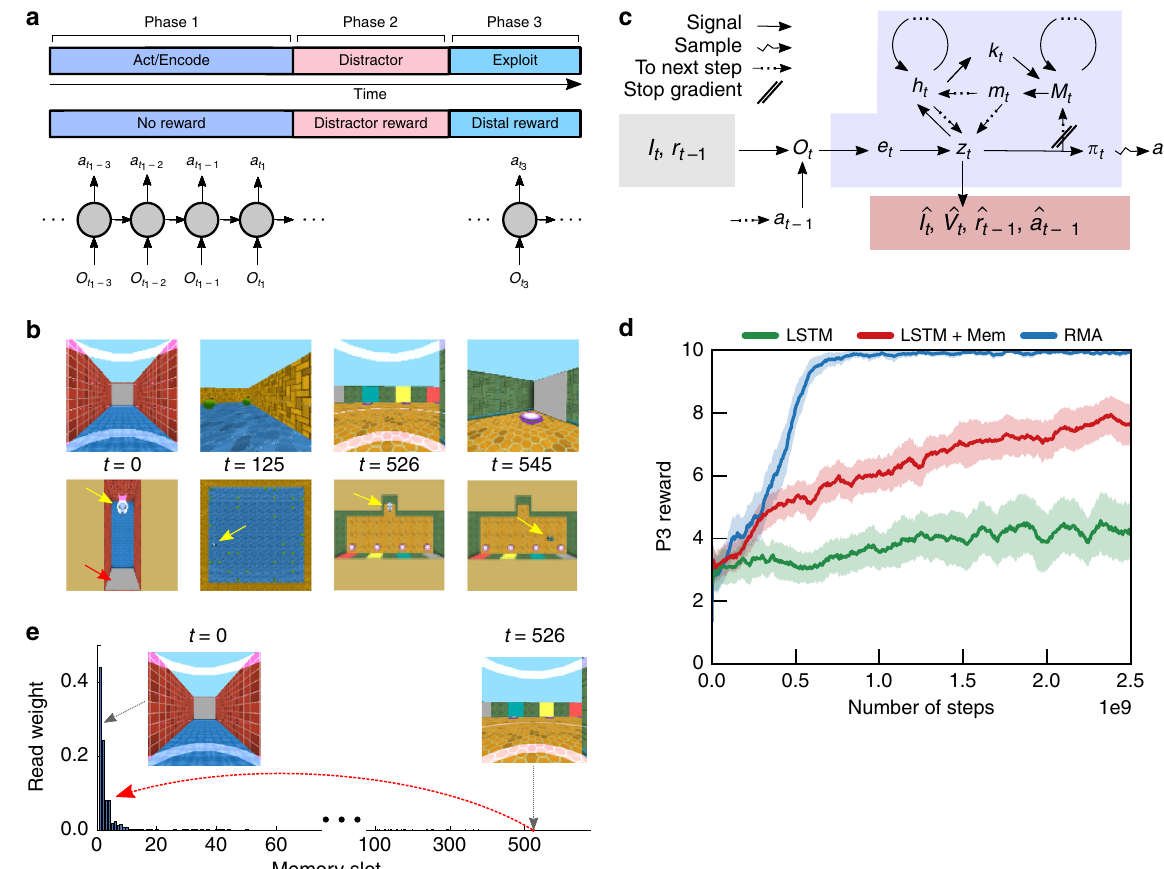
Fig. 1 Task setting and Reconstructive Memory Agent. a The three-phase task structure. In phase 1 (P1), there is no reward, but the agent must seek information or trigger an event. In phase 2 (P2), the agent performs a distractor task that delivers reward. In phase 3 (P3), the agent can acquire a distal reward, depending on its behavior in P1. At each time step, the RL agent takes in observations o t and produces actions a t and passes memory state to